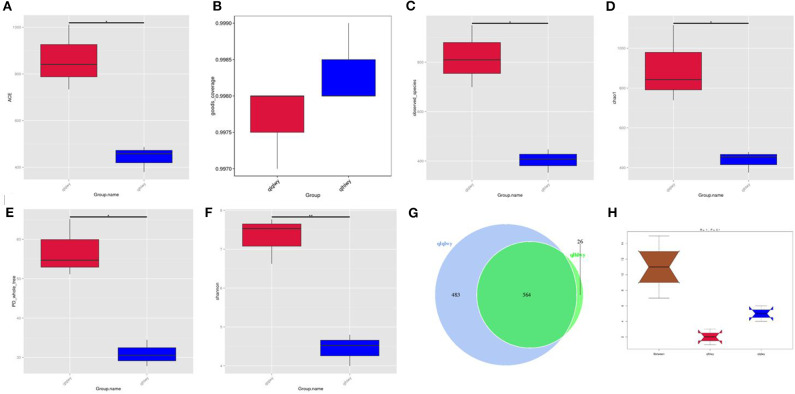
Collation results of DNA sequence data and microbial diversity index analyses. (A) ACE index, (B) Good's coverage index, (C) observed species index, (D) PD whole tree, (E) Chao1 index, (F) Shannon index, (G) Venn diagram. The numbers represent the unique or common OTUs of each group. (H) ANOSIM analysis. “Between” represents the difference between groups; an R-value closer to 1 indicates greater difference. “qlqlwy” and “qlhlwy” represent the two groups.